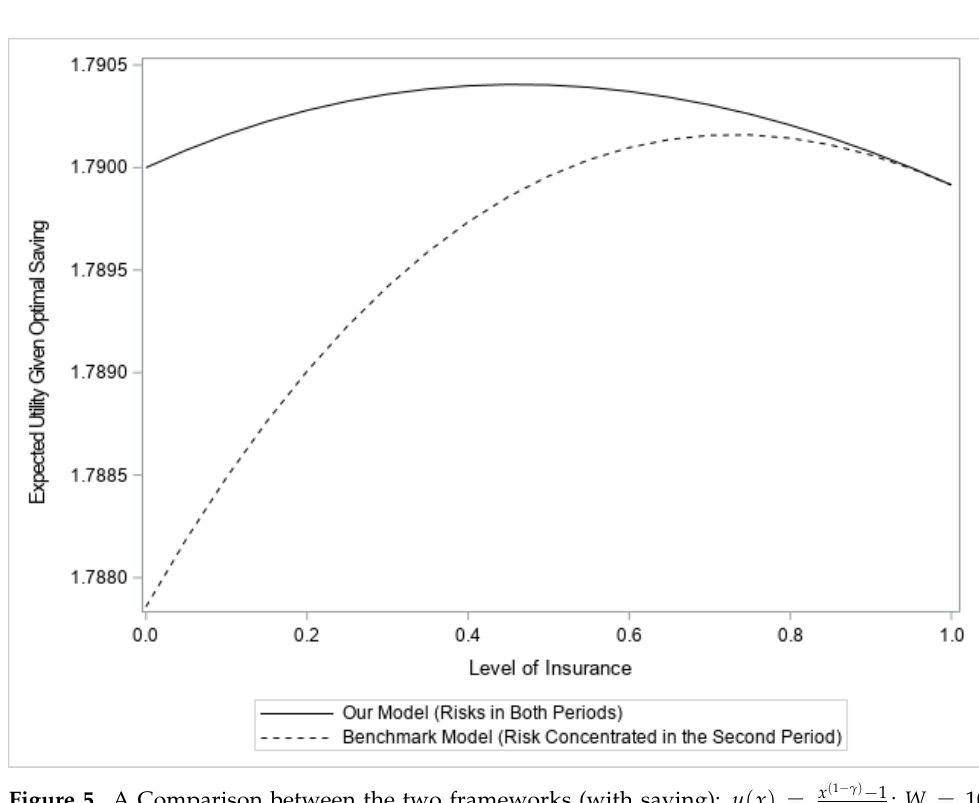
Figure 5. A Comparison between the two frameworks (with saving): u ( x ) = x ( 1 − γ ) − 1 L = 2 l = 4; q = π = δ = 0.2; λ = 0.2; γ =